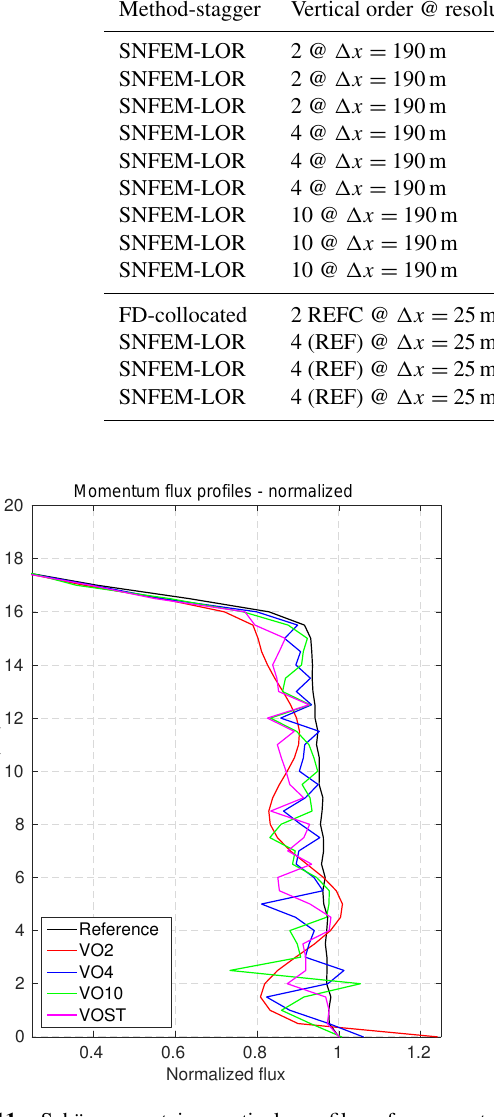
Figure 11. Schär mountain vertical profile of momentum flux for all experiments. The flux profiles are computed by R X (cid:8)(cid:2) ¯ ρ + ρ (cid:48) (cid:3)(cid:2) ¯ u + u (cid:48) (cid:3) w (cid:48) (cid:9) d x at t = 10h where overbars indicate − X initial condition values and primes are departures thereof. Results are interpolated to a regular z coordinate with (cid:49)z = 500m in exper- iments and reference solution to compute the integral flux. Results are normalized to the value at the surface in the reference solution.